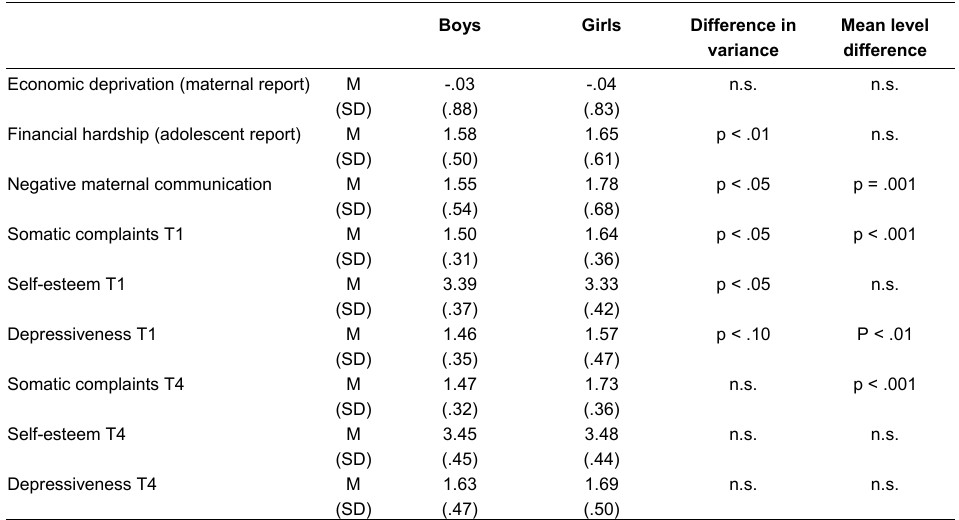
Comparison of indicators by gender